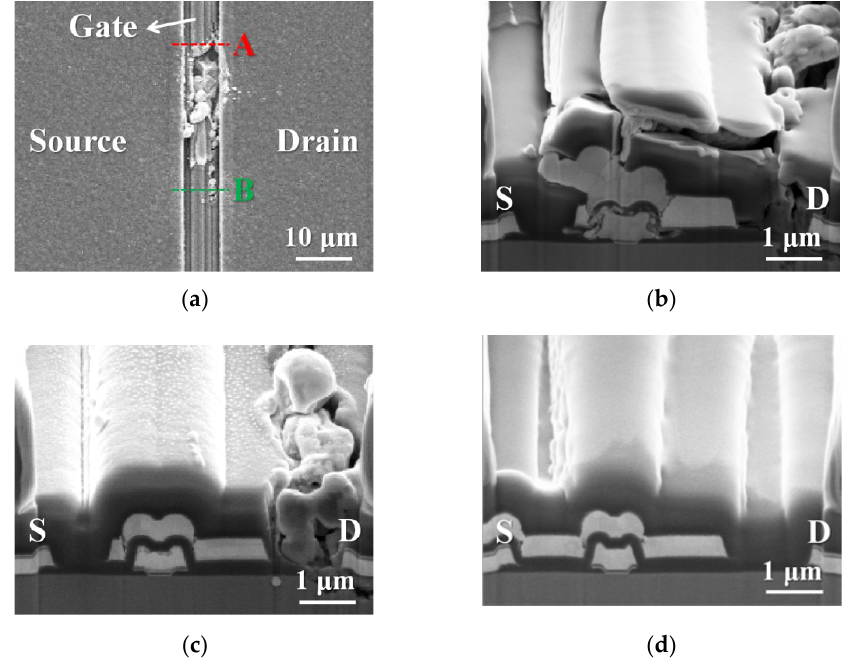
Figure 1. ( a ) SEM surface image of the AlGaN/GaN HEMT after breakdown; ( b – d ) SEM cross-section images of different breakdown and non-breakdown points along the same gate as marked in ( a ).